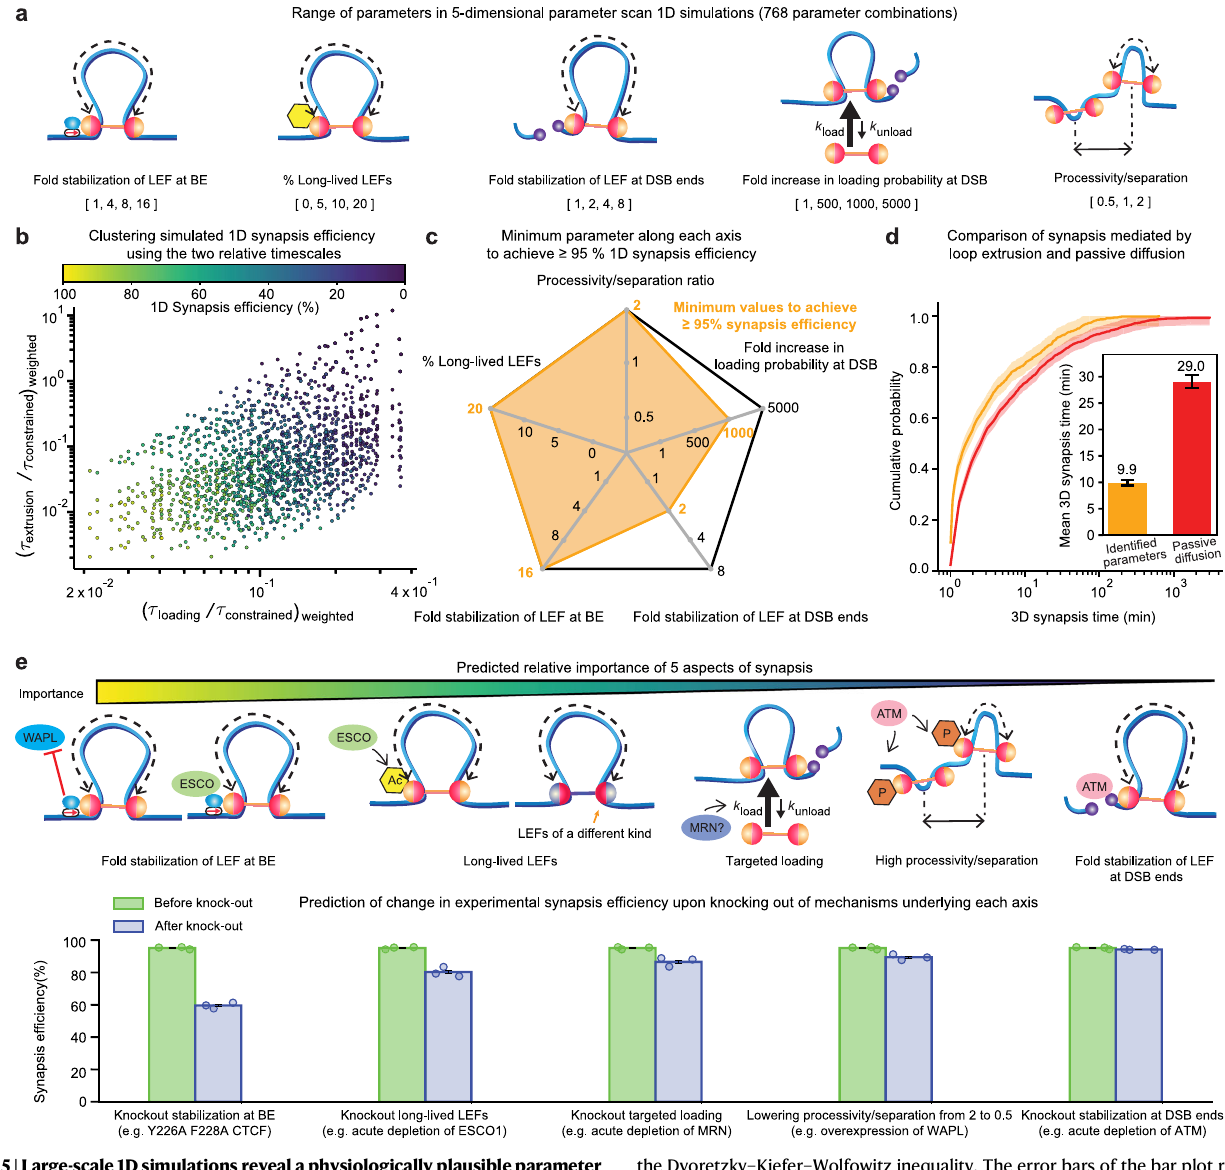
the Dvoretzky – Kiefer – Wolfowitz inequality. The error bars of the bar plot repre- sentsa 95%con fi denceintervalofthe meanusing maximum likelihood estimation oftheexponentialdistributionaccountingforcensoreddata 41 . e The fi veaspectsof synapsis are ranked ordered based on the predicted reduction in synapsis ef fi - ciency upon knocking out the corresponding mechanism. The schematic diagram showsaplausiblemechanisticbasisforeachofthe fi veaspectsofsynapsis.Thebar plot shows the average synapsis ef fi ciency before and after knocking out each of the fi vemechanisms.Theerrorbarsrepresentthestandarderrorofthemean( n =3 differentparametercombinationsthatachieved ≥ 95%synapsisef fi ciency),withthe synapsis ef fi ciency from each parameter combination overlaid as individual dots on the bar